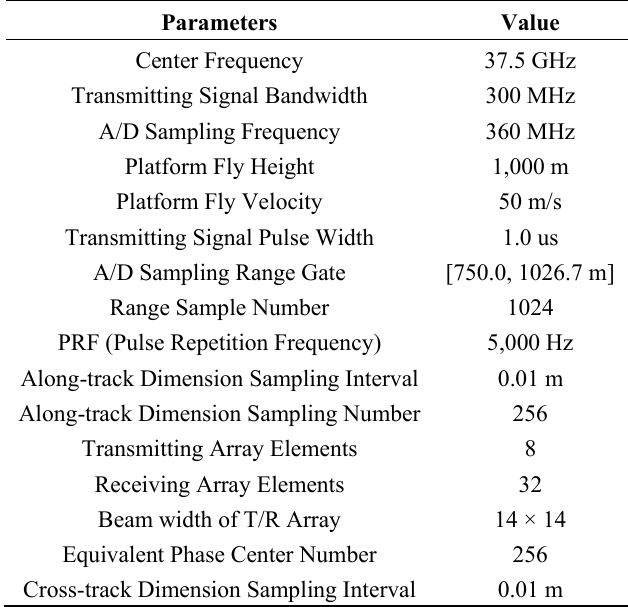
Table 2. Measurement parameters used in the simulation.